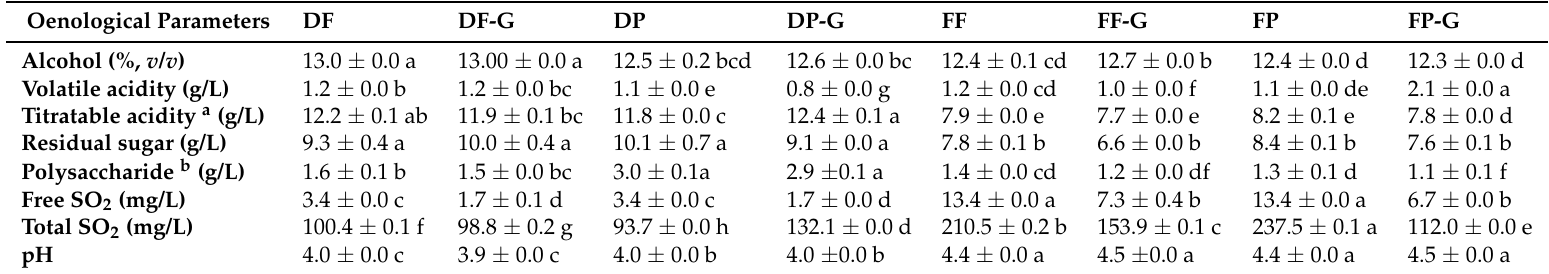
Table 1. Physicochemical parameters of goji berry fermented